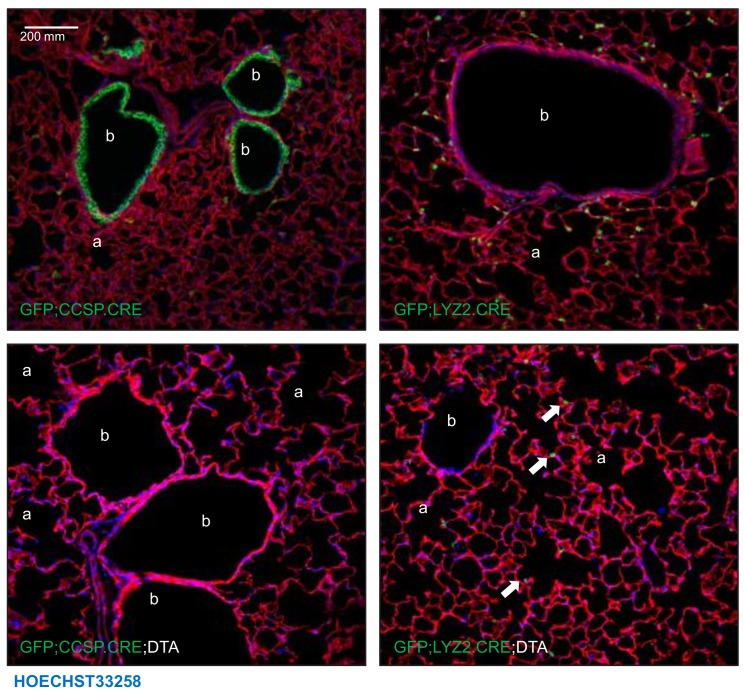
Triple transgenic mouse models for validation of genetic pulmonary lineage ablation: representative images.Representative lung sections of 12-week-old GFP;CCSP.CRE, GFP;LYZ2.CRE, GFP;CCSP.CRE;DTA, and GFP;LYZ2.CRE;DTA mice (n = 6/group). Shown are merges of Hoechst 33258-stained endogenous TOMATO- and GFP-labeling. Note increased bronchial (b) and alveolar (a) size, complete airway epithelial denudement, and prominent distortion of bronchial and alveolar structure of GFP;CCSP.CRE;DTA mice compared with other strains, mimicking chronic obstructive pulmonary disease. Note also the presence of some GFP-labeled alveolar macrophages in GFP;LYZ2.CRE;DTA mice (arrows). a, alveoli; b, bronchi.